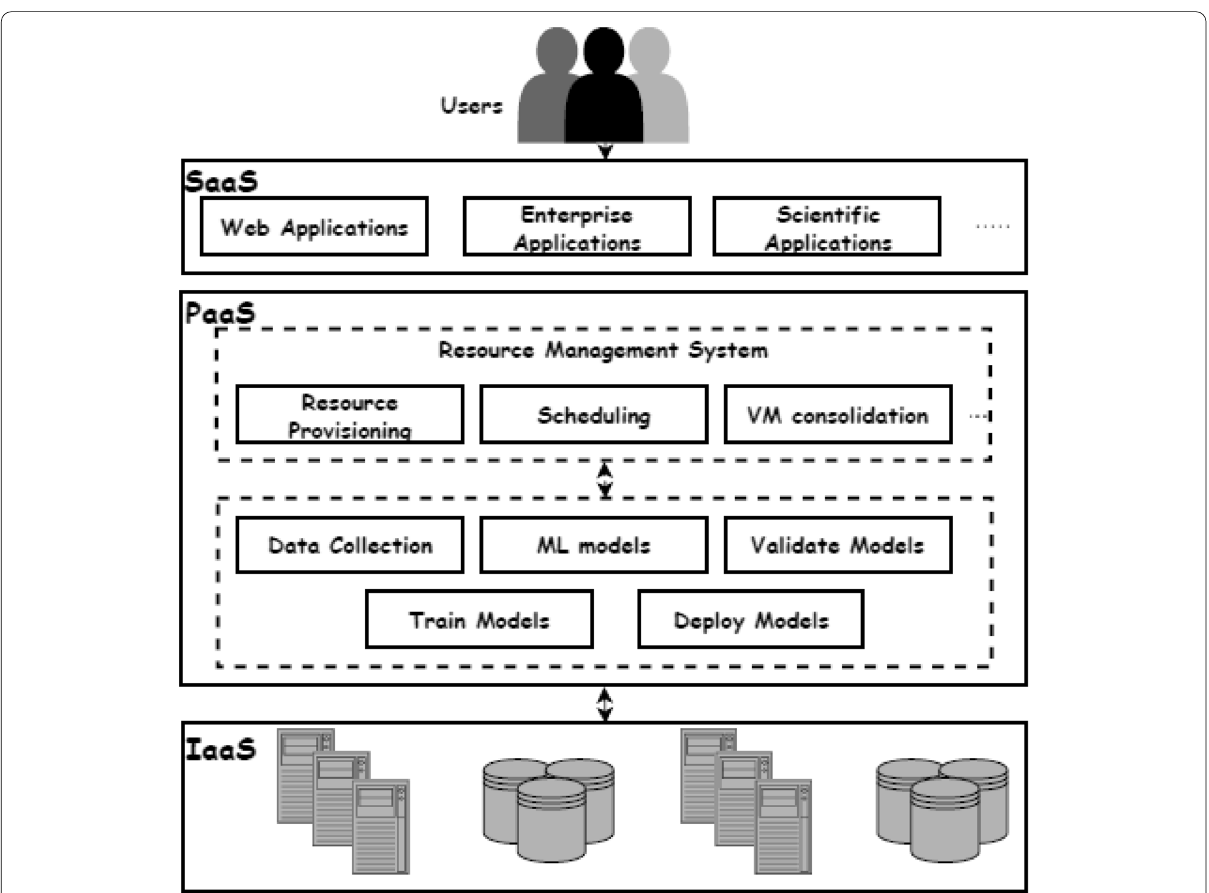
Fig. 1 Machine Learning-based Cloud Computing Conceptual Components